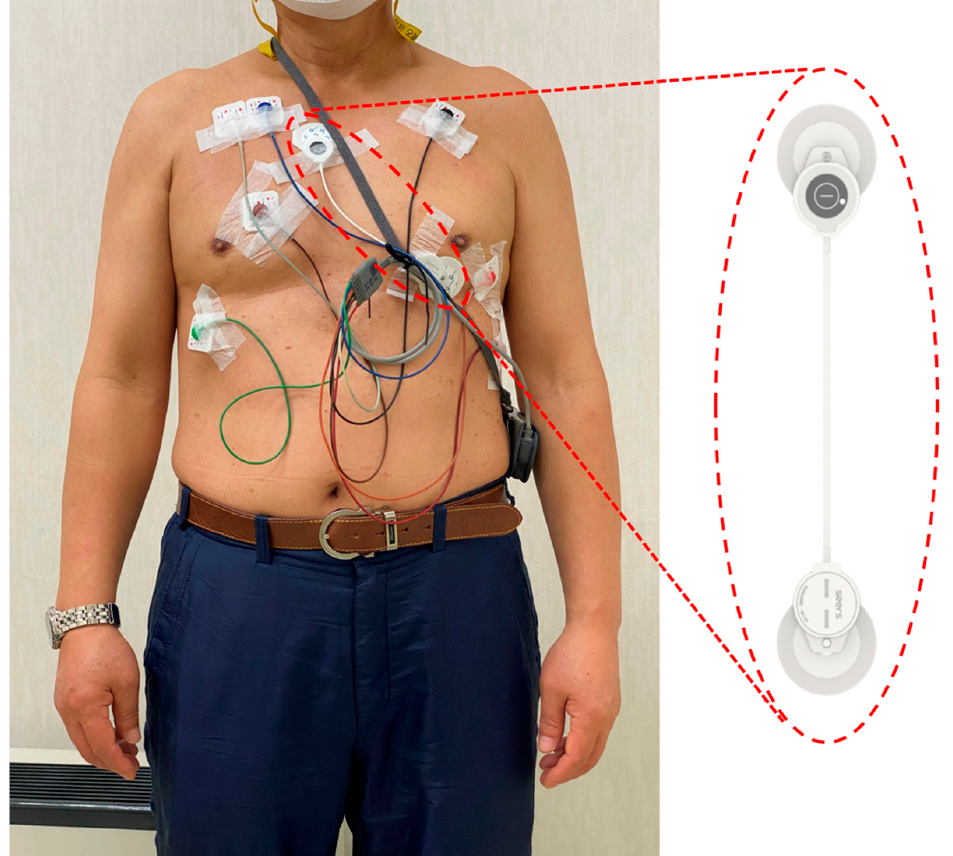
Figure 1. The measurement setting for ECG monitoring of a study participant. The left panel shows a participant wearing a Holter monitoring and an adhesive single-lead ECG monitoring device (mobiCARE-MC100) simultaneously. The right panel shows the product appearance of mobiCARE-MC100. Abbreviation: ECG, electrocardiogram. Table 1. The specification of the MC-100.